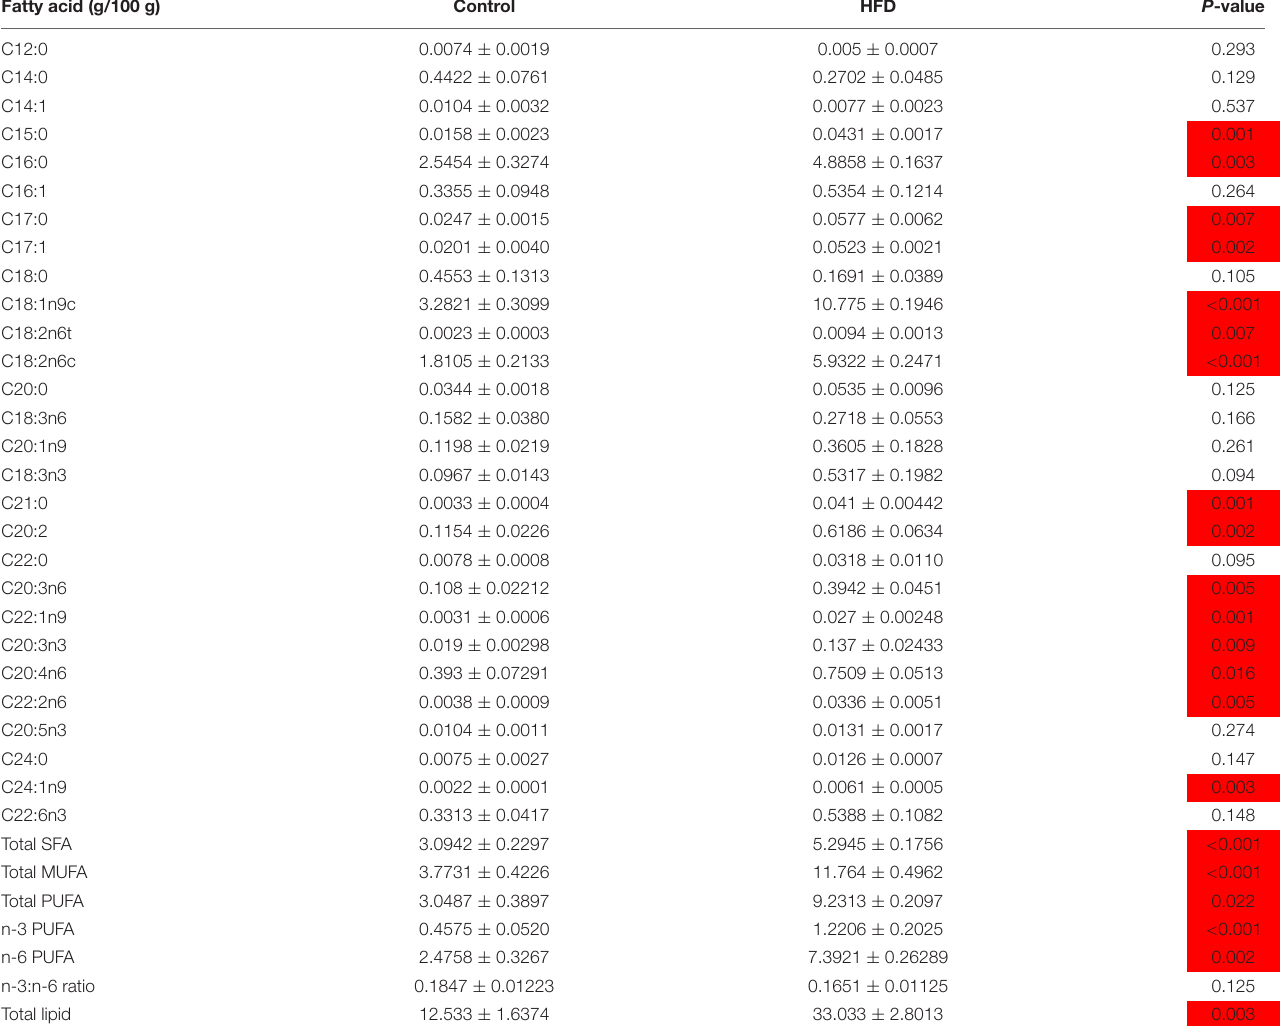
TABLE 1 | Fatty acid composition in the livers of control diet or HFD-fed tilapia after 90 days. Fatty acid (g/100 g) Control